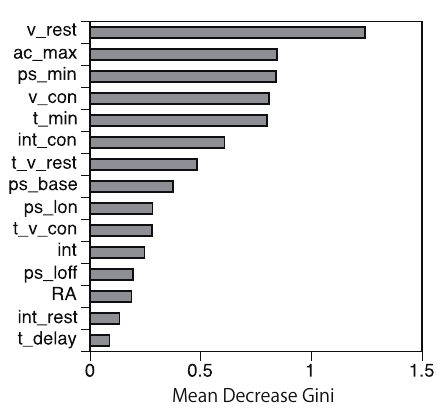
Figure 8. Contribution weights in features of b100 condition for the